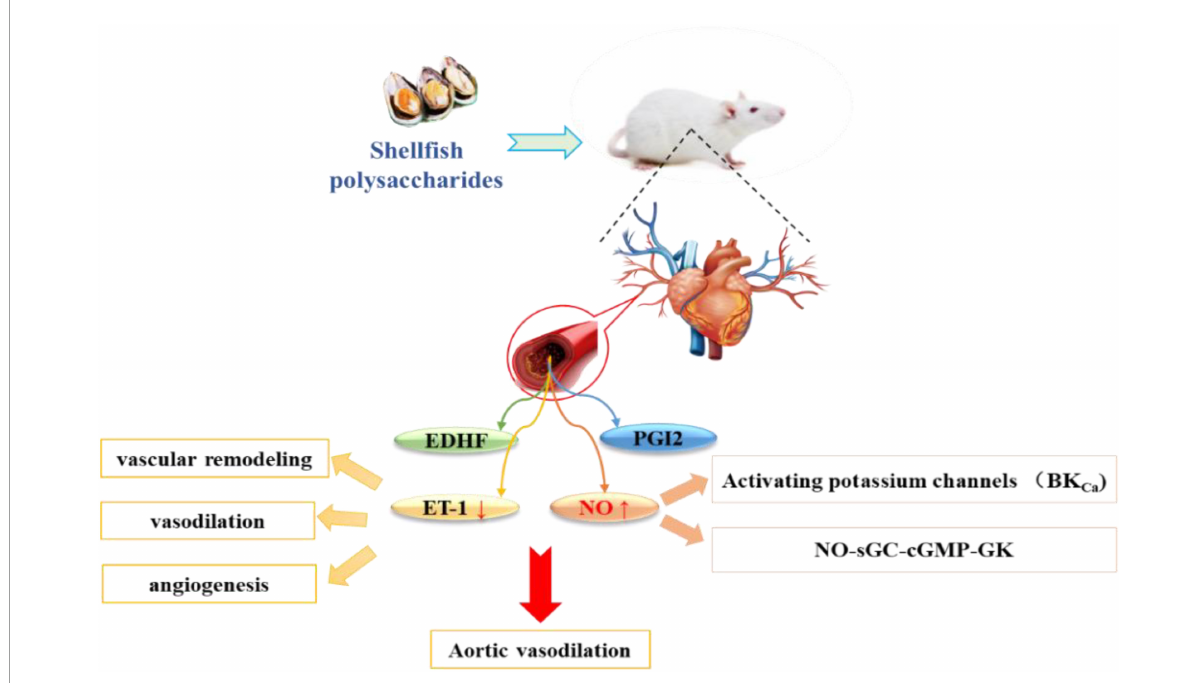
FIGURE4 Shellfish polysaccharides regulate vasodilation factors and reduce high blood